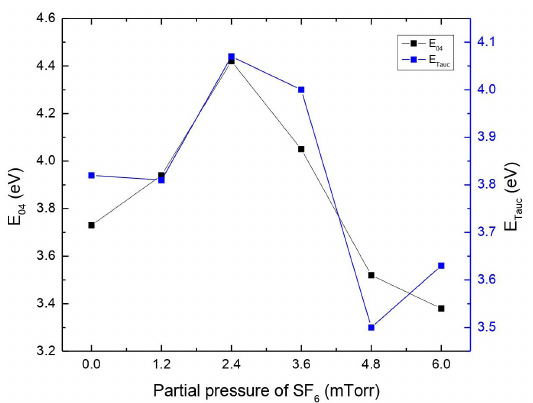
. Figure 12. Urbach energy as a function of the Tauc SF